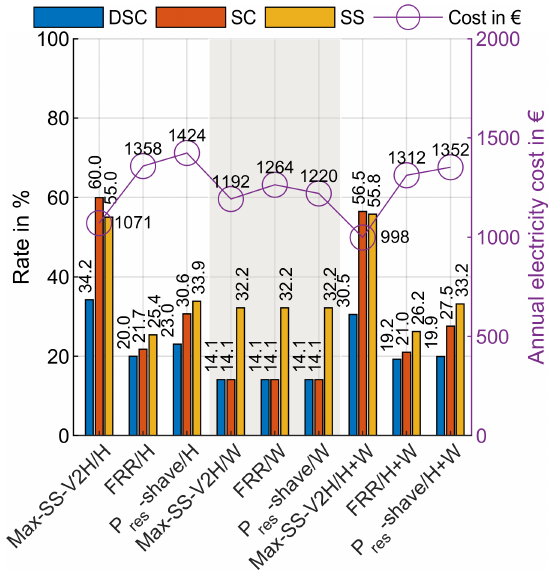
Figure 11. DSC, SC, and SS rates, and electricity cost for scenarios with SoC V 2 XLimit = 23%.